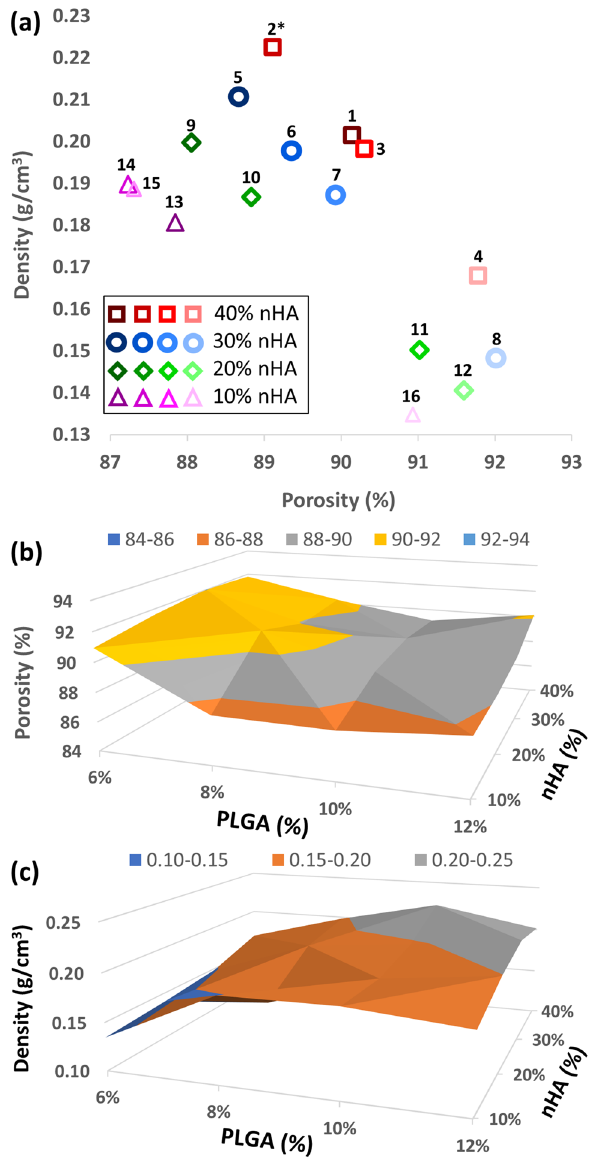
Fig. 3 a Density vs. porosity for the 16 scaffolds listed in Table 1. The set of scaffolds containing 40%, 30%, 20%, and 10% nHA have been identified in the image. The darker the color of the symbols, the higher the PLGA concentration (i.e., 12%, 10%, 8%, and 6%). (*) The density and porosity of scaffold #2 was averaged over 2 sam- ples, whereas the remaining scaffolds were averaged over 3 sam- ples (1, 3, 4, and 5) or 4 samples (6–16); b & c The 3D surface plots of scaffold porosities and densities versus nHA content and PLGA